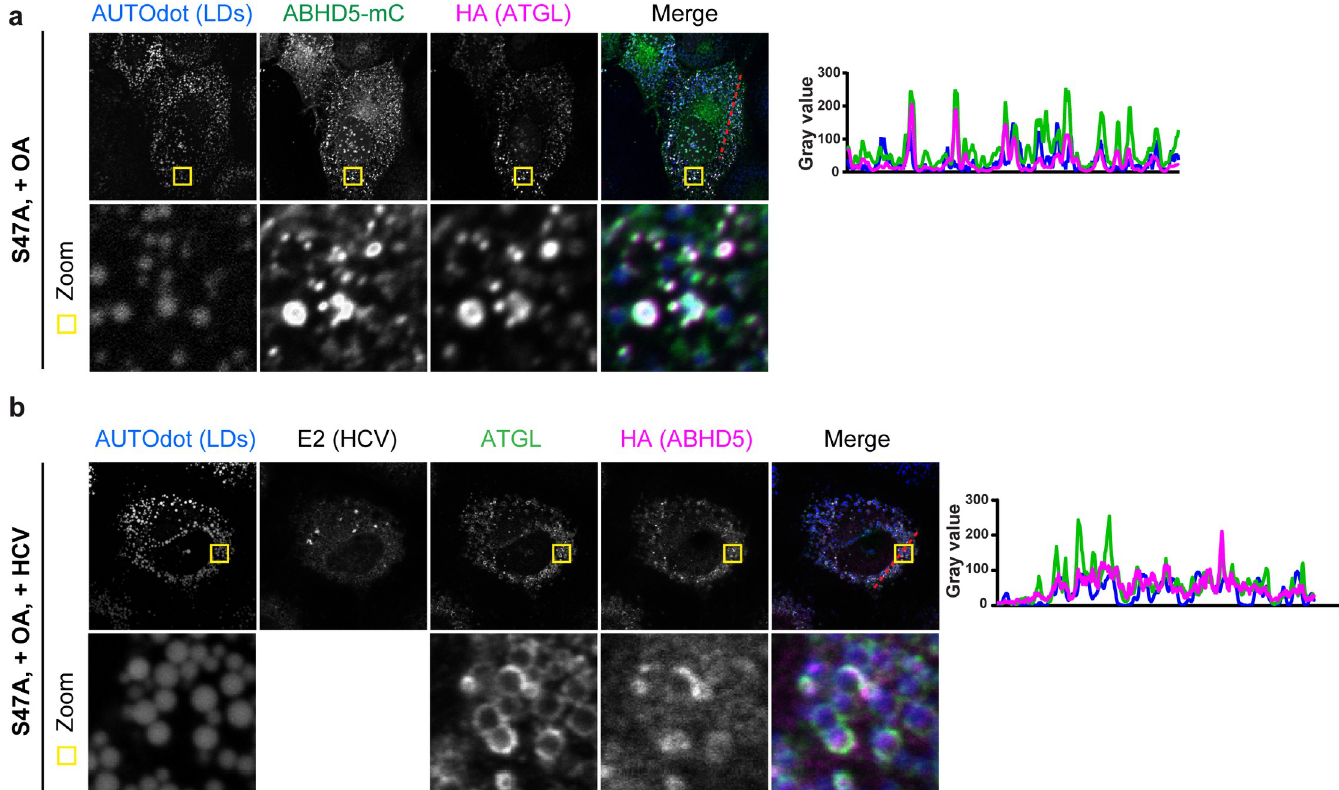
Fig 3. ABHD5 and ATGL colocalize at the lipid droplet surface. ABHD5 and ATGL S47A were expressed by lentiviral transduction and detected by indirect immunofluorescence using antibodies against the respective epitope tag or by their auto-fluorescence in case of the ABHD5-mCitrine fusion protein. Colocalization between the proteins or with the lipid droplet marker AUTOdot was tested in naive ( a ) or HCV-infected ( b ) Lunet N hCD81 cells after oleic acid (OA) induction. ( a ) Subcellular localization of HA-tagged ATGL S47A relative to ABHD5-mCitrine (mC) and lipid droplets. ( b ) Subcellular localization of HA-tagged ABHD5 relative to ATGL S47A and lipid droplets, in HCV-infected cells. HCV infection was verified by immunostaining against HCV E2 glycoprotein. In ( a ) and ( b ) the plots on the right side indicate the intensity profiles in the different channels along the red dotted line depicted in the merge picture.